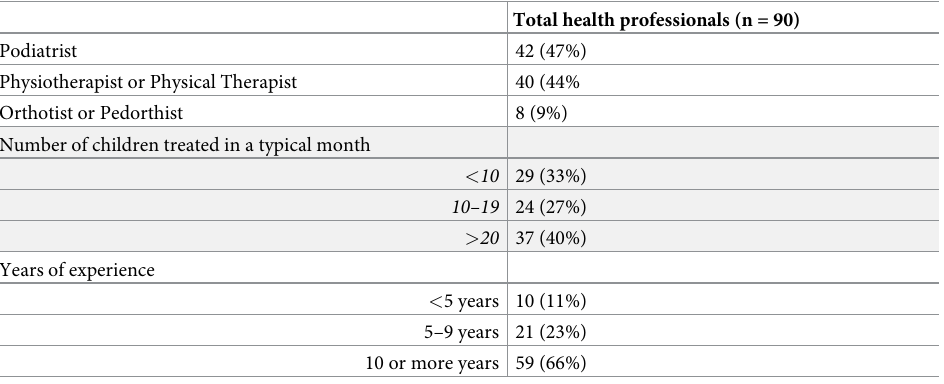
Table 2. Health professional participant demographics (n = 90).